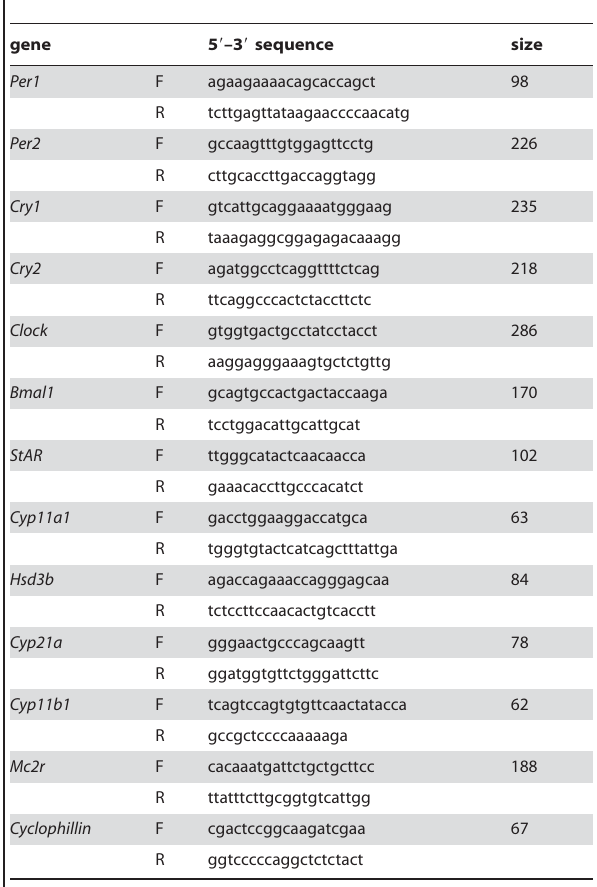
Table 1. Primers used for real-time